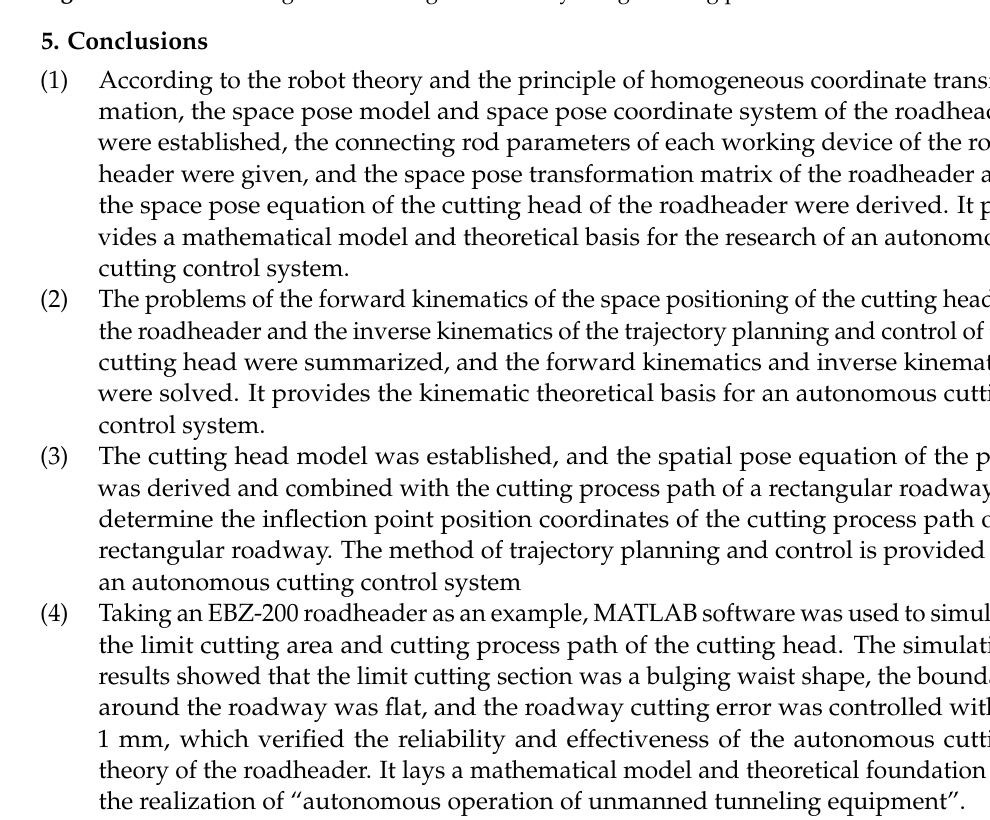
Figure 9. Simulation diagram of rectangular roadway design cutting path.